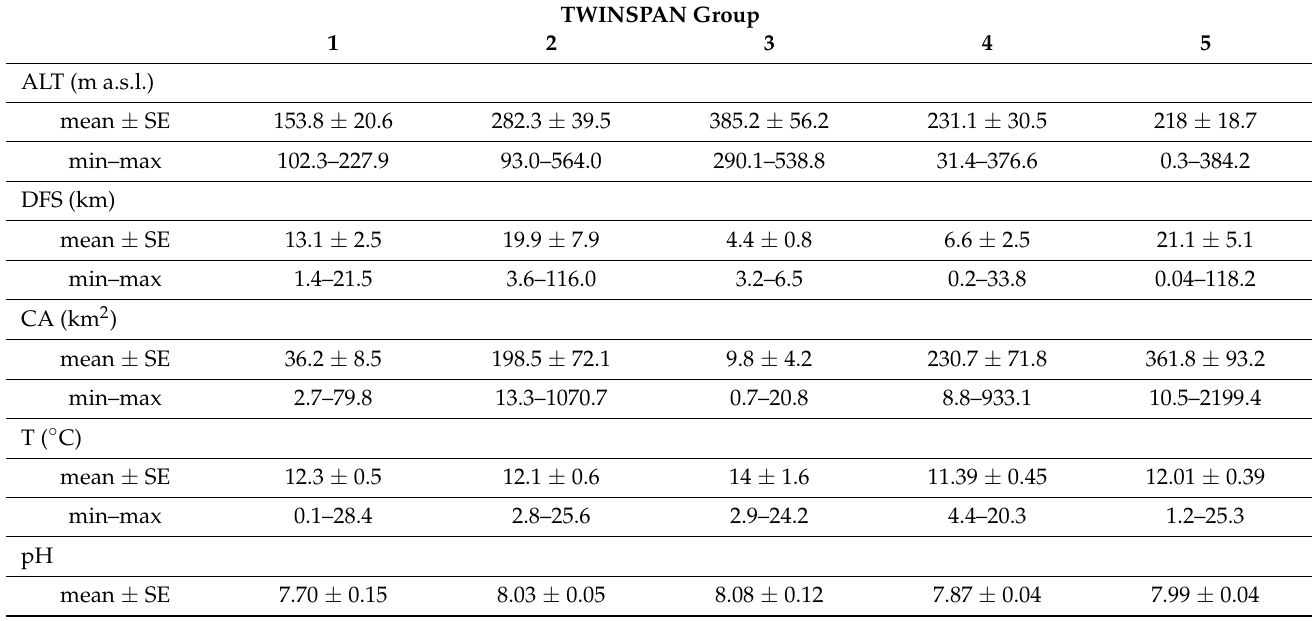
Table A2. Basic descriptive statistic (mean ± SE and range (min–max)) of 35 environmental variables (for abbreviations, see Table 5). TWINSPAN